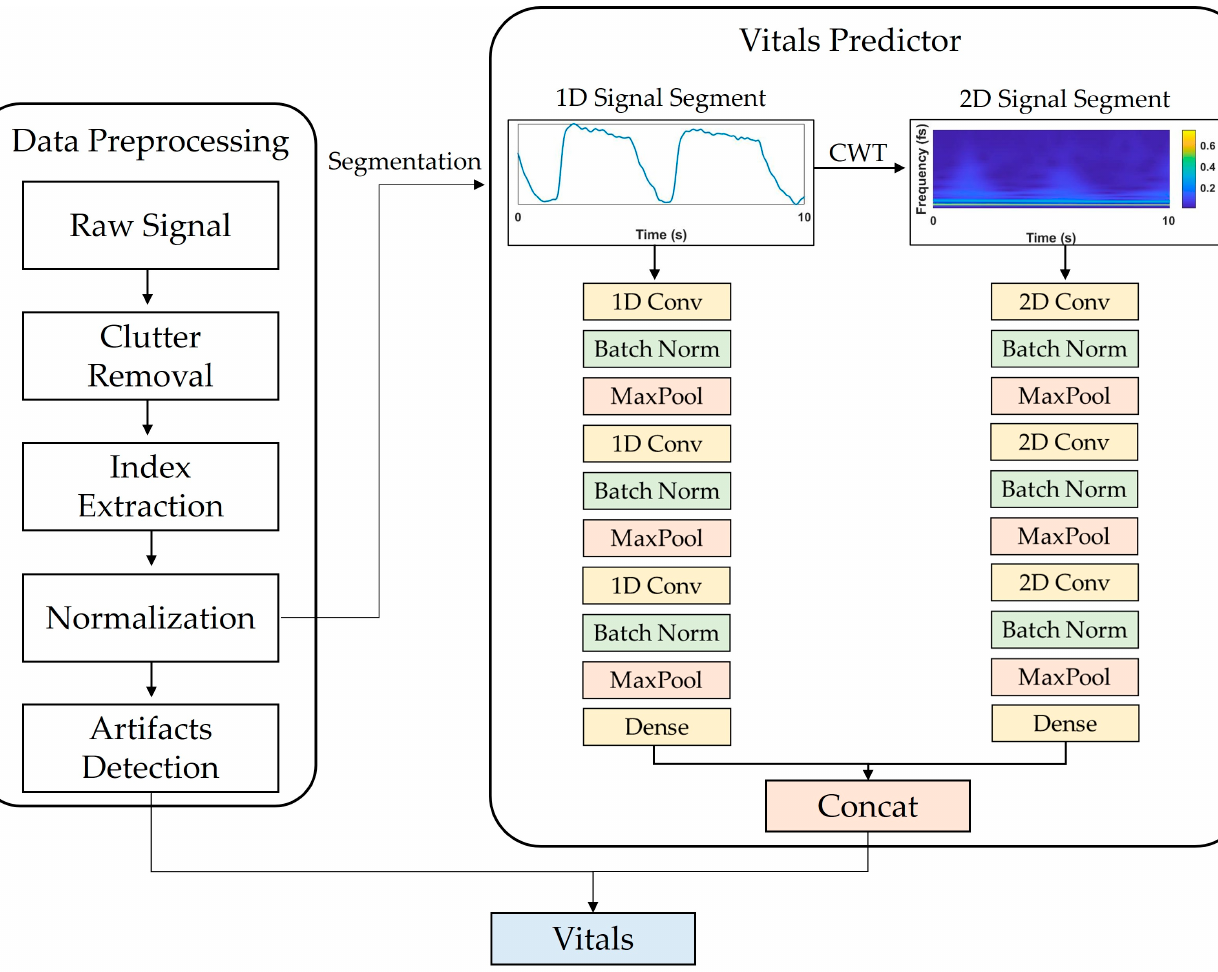
Figure 1. Overview of proposed DL model framework for estimating vital signs using IR-UWB radar signals. It consists of data preprocessing and vitals predictor parts. In data preprocessing, input data segments are extracted through clutter removal, index extraction, and normalization. In vitals prediction, the extracted segments are input into the CNN model that processes 1D and 2D signals, and RR and HR are extracted as final outputs.